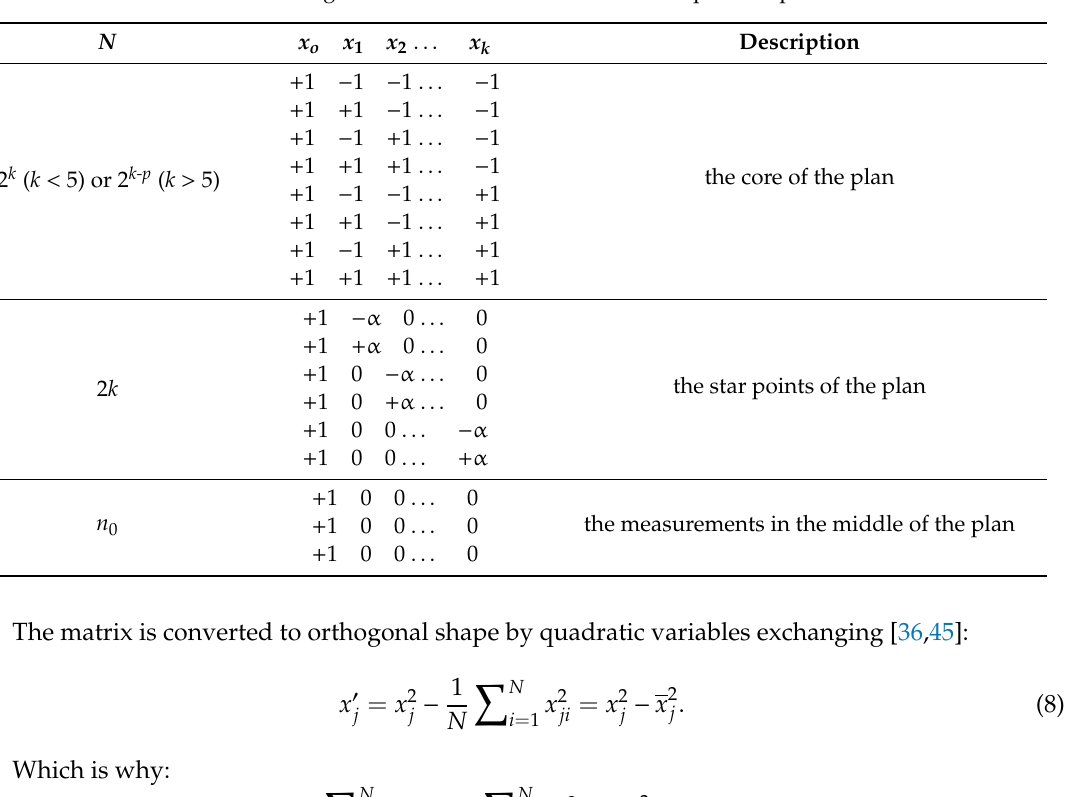
Table 3. The general form of the matrix of the composition